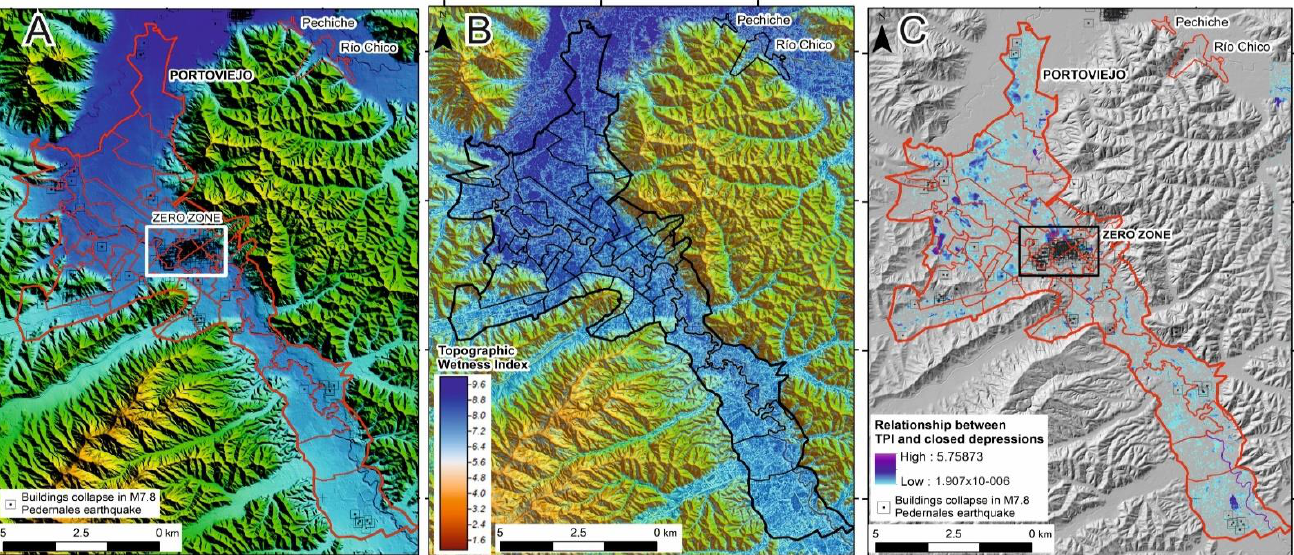
Figure 7. Special projection of buildings that collapsed after the Pedernales earthquake (Mw 7.8) on 16 April 2016. ( A ) Portoviejo urban area is located in a narrow river valley area. ( B ) Analysis of the topographic wetness index and topographic position index. ( C ) Delineation of potential saturated soils from geomorphological analysis.